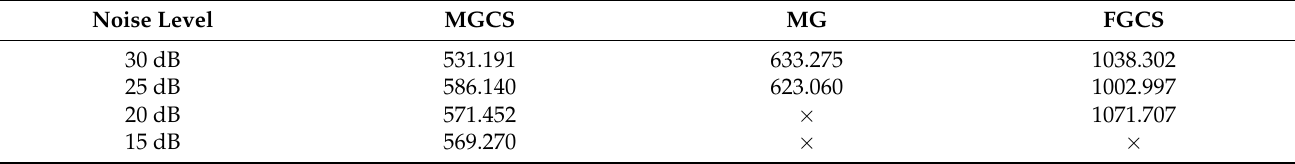
Figure 5. The inversion results by MG with different noise levels; ( a , b ) are the identified porosity images with 30 and 25 dB Gaussian noises, respectively. Table 1. The CPU execution times (seconds) by three different methods.